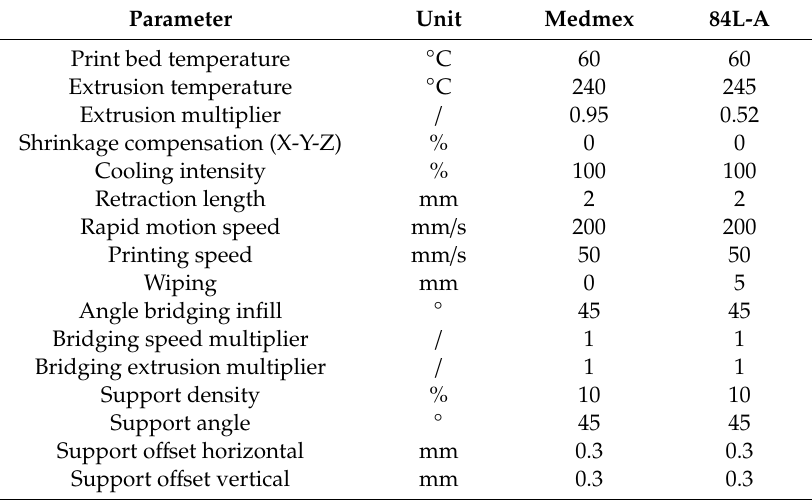
Table 6. Thermoplastic polyurethane (TPU) parameter table, nozzle: 0.4 mm [7].